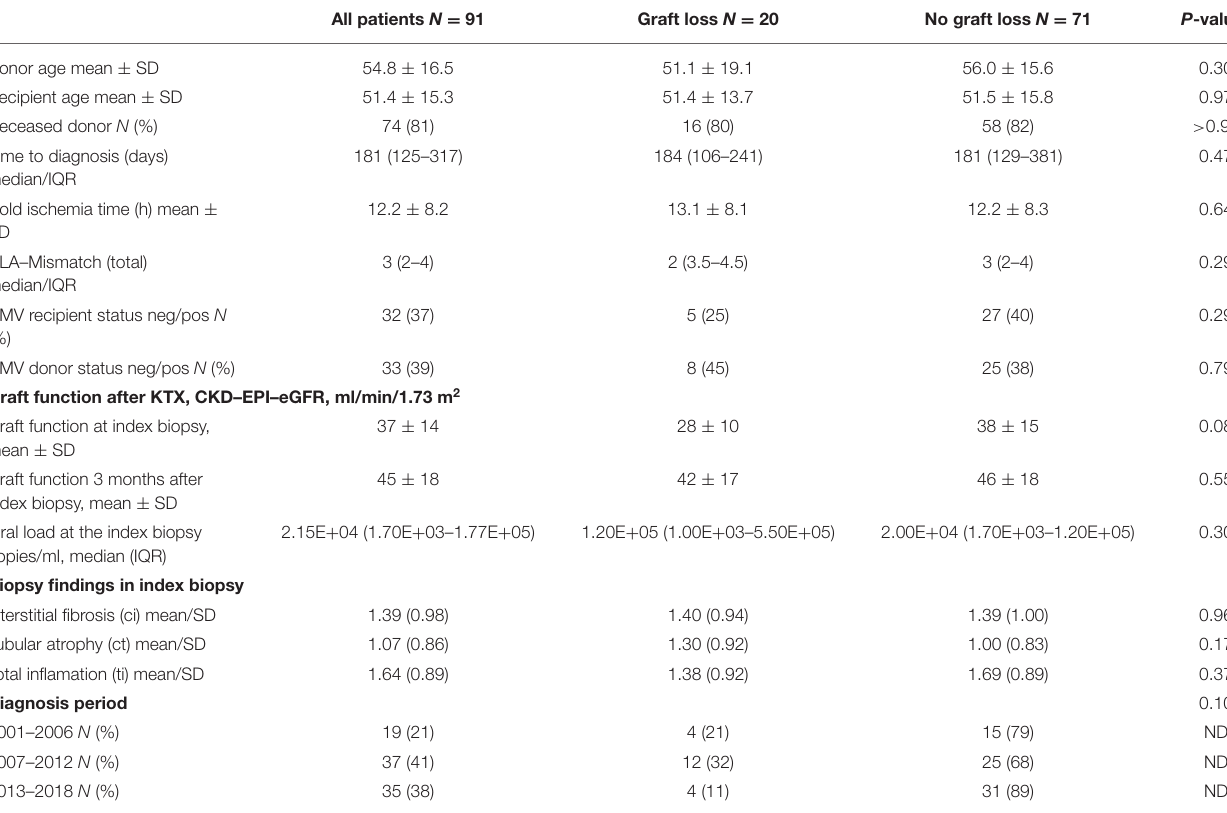
TABLE 4 | Transplant and demographic patient characteristics in relation to a graft loss. All patients N =